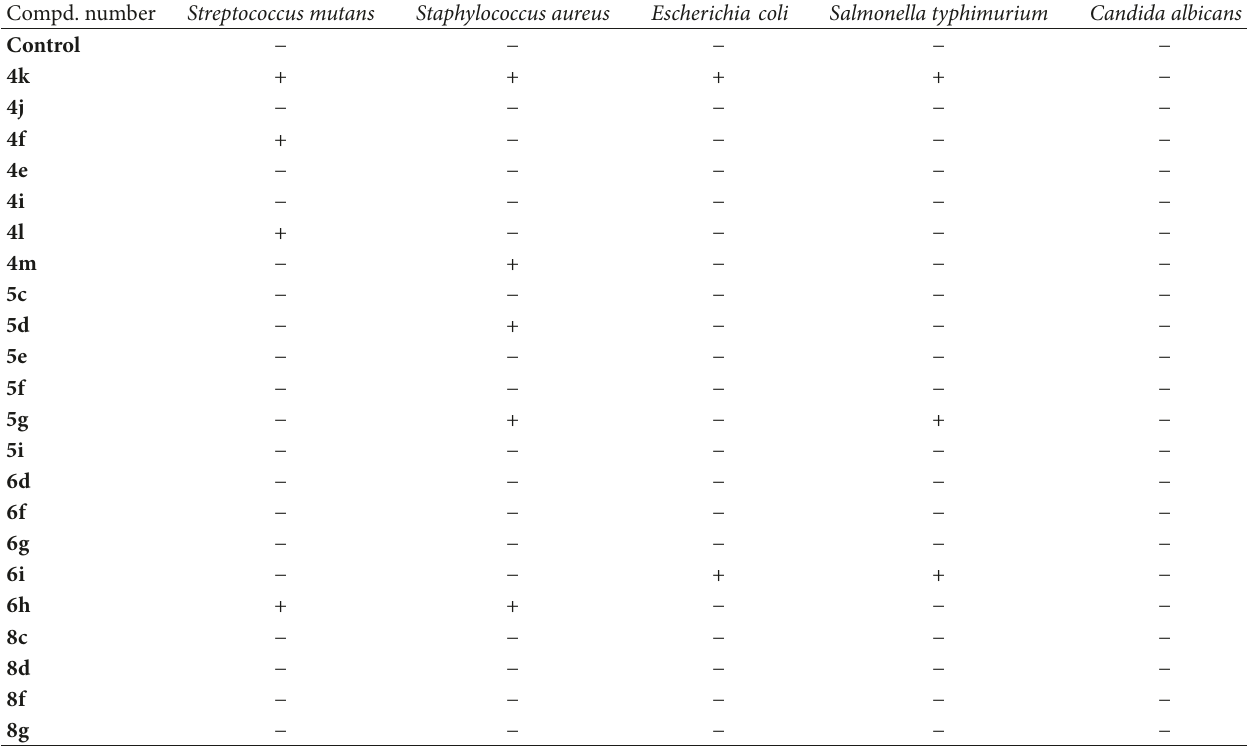
Table 1: Bioactivities of the synthetic organic compounds against some pathogenic bacteria and unicellular fungus Candida albicans at 100 𝜇 g/paper disc (6mm).